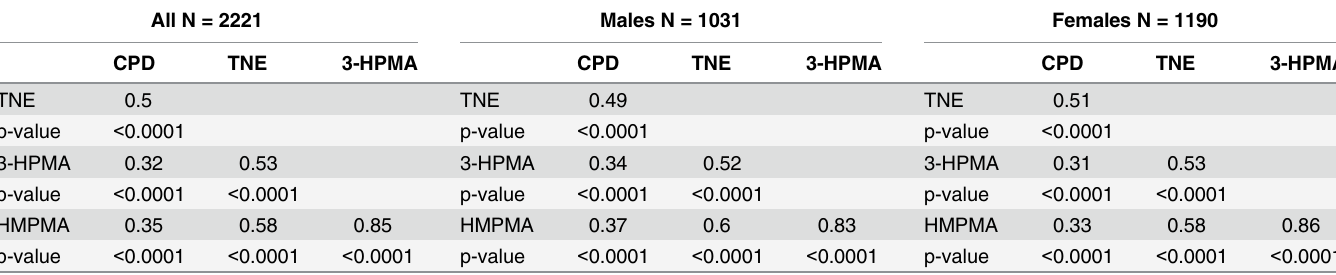
Table 2. Pearson's correlation between measures of smoking and 3-HPMA and HMPMA. a